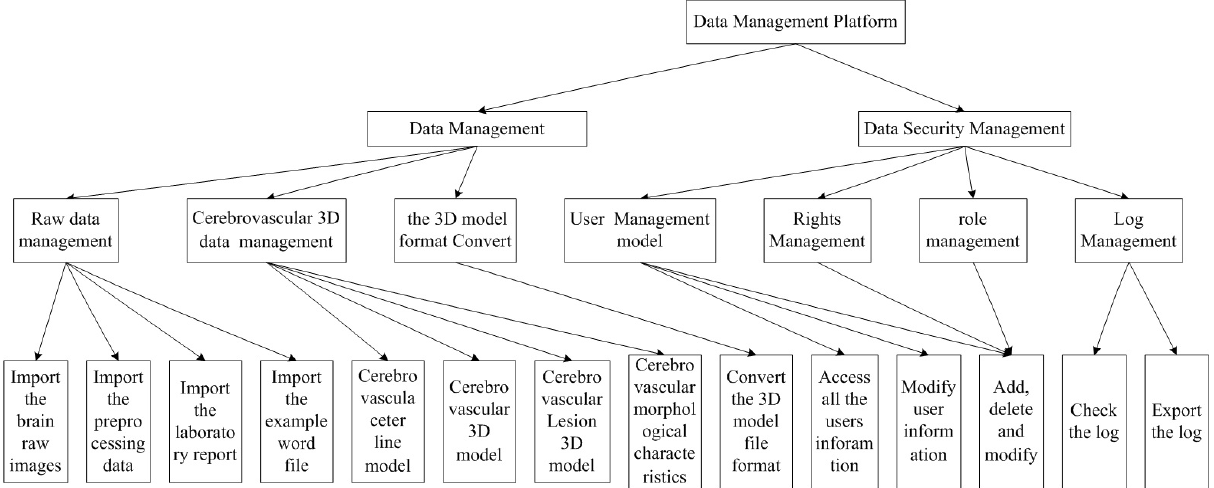
Figure 3. Platform of database